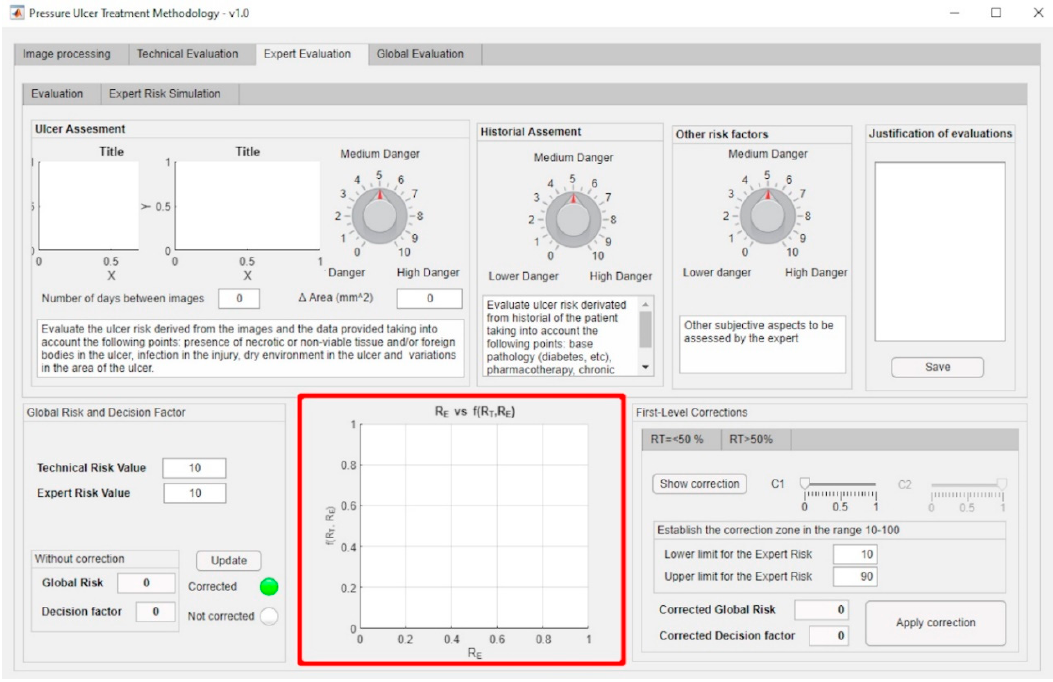
Figure 11. Panel for the definition of the curves’ model.